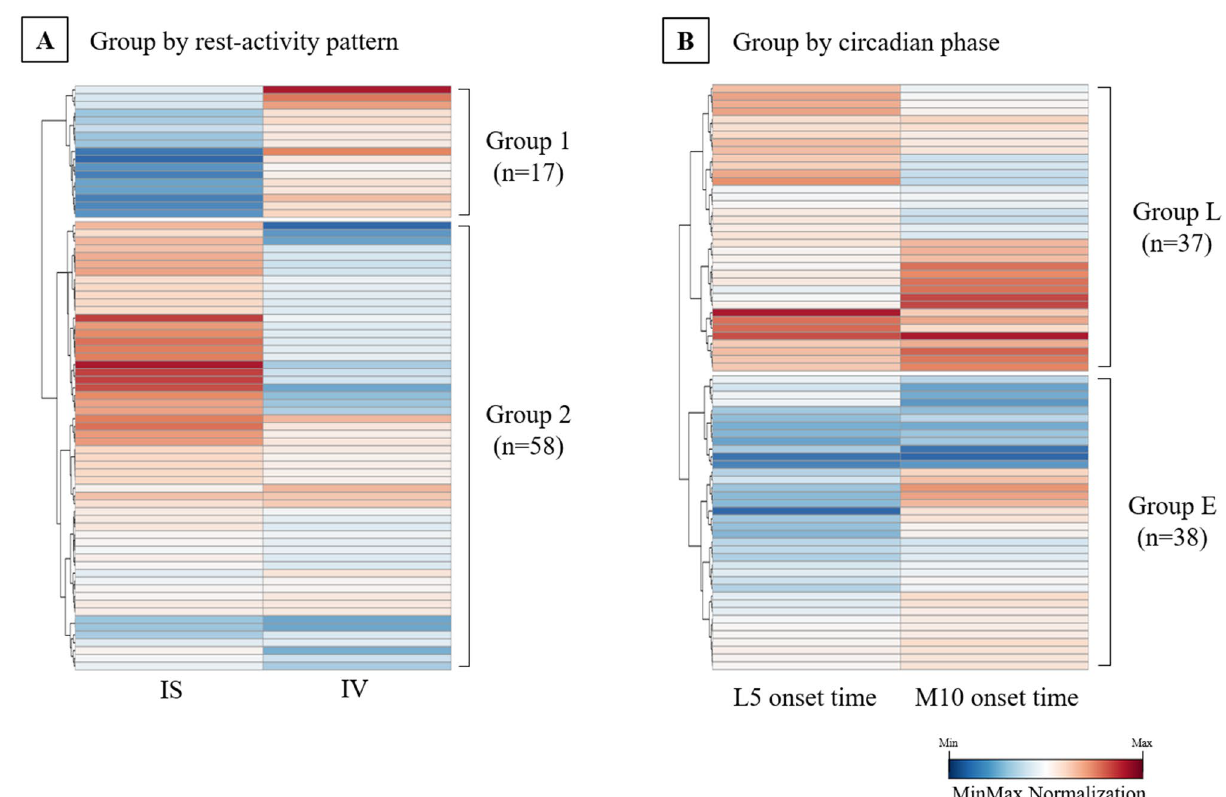
Figure 1. Data-driven group classification of participants based on actigraphy-derived rest-activity patterns and circadian phase. Hierarchical clustering analysis was performed for the data-driven group classification. ( A ) Groupclassification according to the rest-activity patterns. ( B ) Group classification according to the circadian phase. In ( B ), the L5 onset time and M10 onset time were converted to the numeric values. For example, the L5 onset time of 11:30 p.m. was treated as 23.5, and the L5 onset time of 01:15 a.m. was treated as 25.25. We performed Min–Max normalization in each variable for visualization. IS inter-daily stability, IV intra-daily variability, L5 onset time least active 5-h onset time, M10 onset time most active 10-h onset